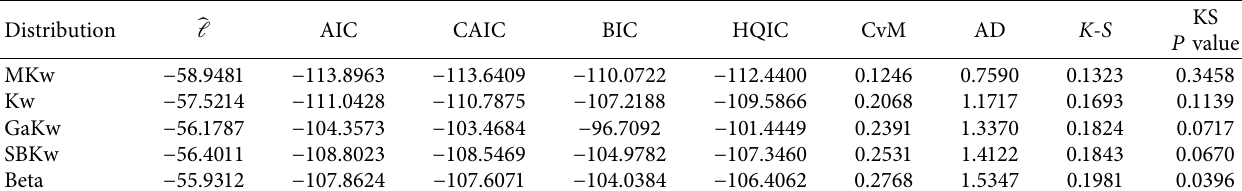
Table 13: Te statistics AIC, CAIC, BIC, HQIC, CvM, AD, and K - S for data set